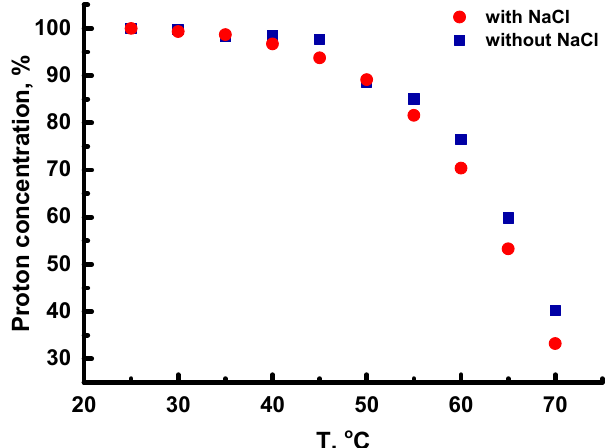
Figure 5. The temperature dependence of the concentration of protons at the C 2 carbons of histidine imidazole rings (8.12 ppm) during heating.